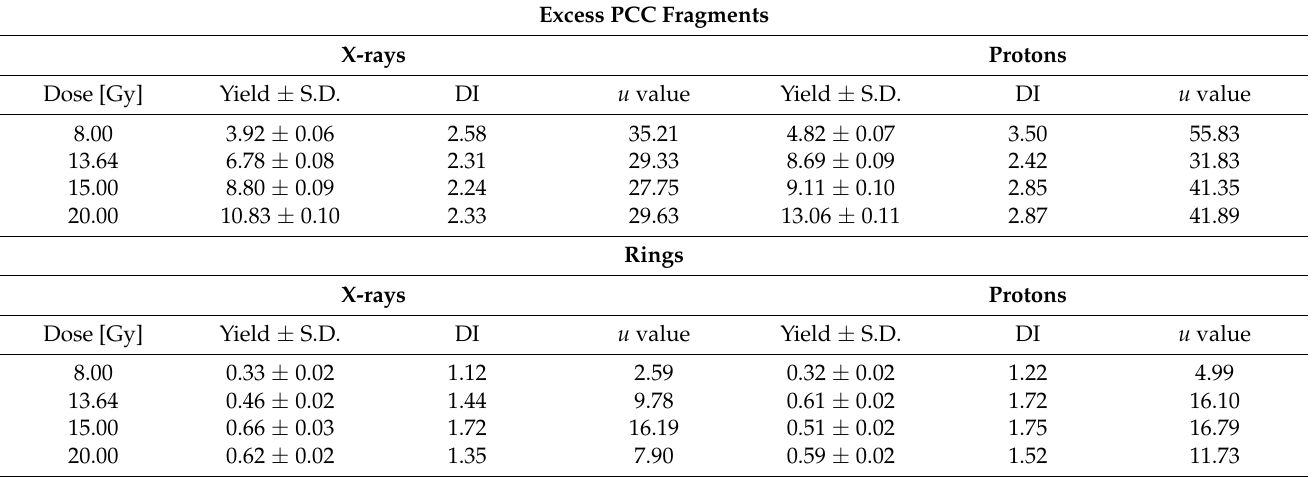
Table 1. The yield ± S.D., dispersion index (DI), and u -values ( u ) of excess fragments and rings induced in X-ray and proton-irradiated lymphocytes pooled for each dose from all donors. Values were calculated to test if the distribution of aberrations followed a